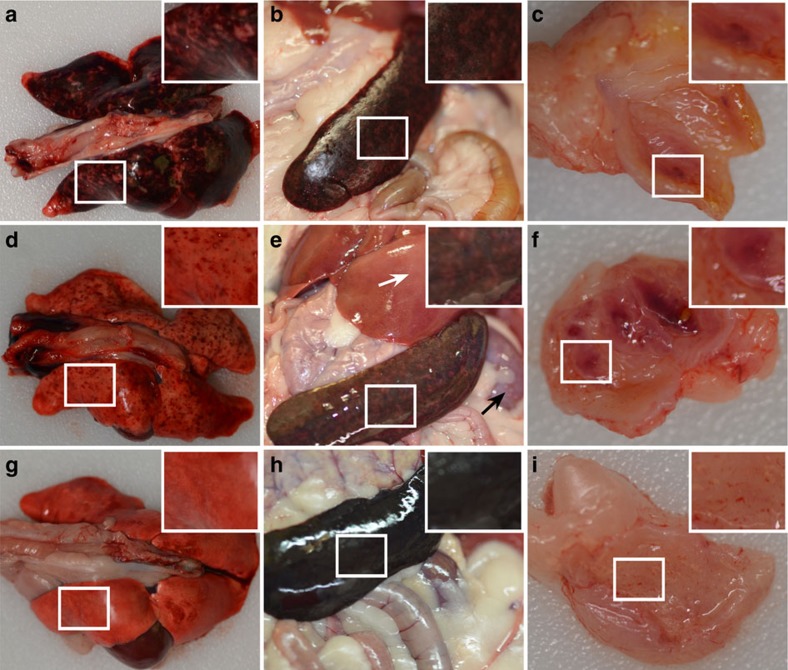
Gross pathology of lungs, spleens and urinary bladders from rNiVM-infected ferrets.Representative gross pathology of lungs (a,d,g), spleen (b,e,h) and urinary bladders (c,f,i) taken from ferrets infected with rNiVM-wt (a–c), rNiVM-Wko (d–f) and rNiVM-Vko (g–i). Inserts show magnified regions of each specimen. Multifocal to coalescing haemorrhage and necrosis of all lung lobes is seen in rNiVM-wt-infected ferrets (a), while much fewer and smaller numbers of haemorrhagic and necrotic foci are seen in rNiVM-Wko-infected ferrets (d). Splenomegaly and multifocal necrosis are seen in spleens from rNiVM-wt (b)- and rNiVM-Wko (e)-infected ferrets. Kidneys from ferrets infected with rNiVM-Wko showed multifocal haemorrhage and necrosis (e, black arrow) and livers were diffusely pale and reticulated (e, white arrow). Similar lesions were seen in rNiVM-wt-infected ferrets (not shown). Very minimal to no pathology was observed in lungs (e) and spleens (f) from rNiVM-Vko-infected ferrets. Urinary bladders showed large haemorrhagic lesions in ferrets infected with rNiVM-wt (c) and rNiVM-Wko (f); very small, multifocal haemorrhagic lesions seen in the urinary bladder of ferret rNiVM-Vko-4 (i); no lesions were observed in the urinary bladders of the other ferrets from the rNiVM-Vko cohort.